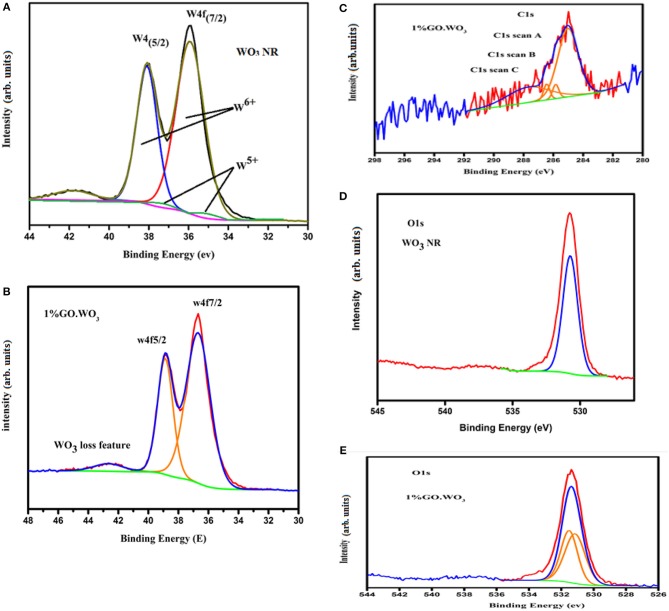
W 4f XPS spectra of WO3
(A) and 1%GO.WO3
(B), beside the C1S of 1%GO.WO3
(C), and O1S of WO3
(D) and 1% GO.WO3
(E) catalysts.